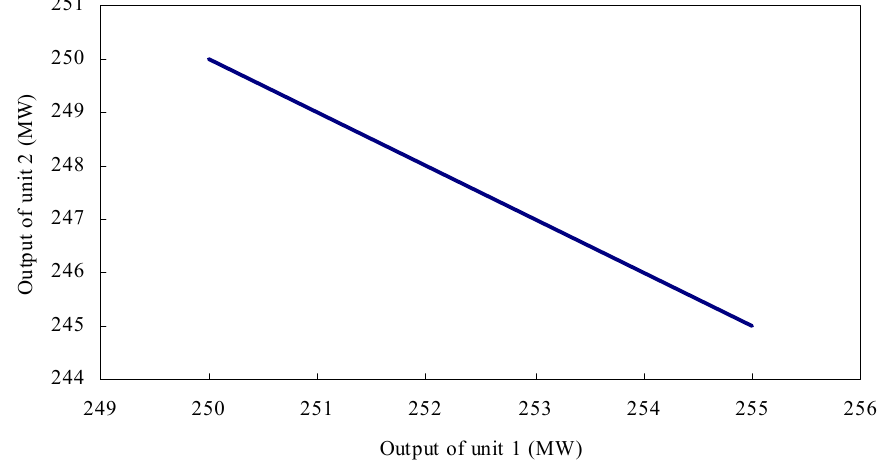
Figure 6. Multiple solutions to total electric load of 500 MW (output of unit 1 ≥ output of unit 2).